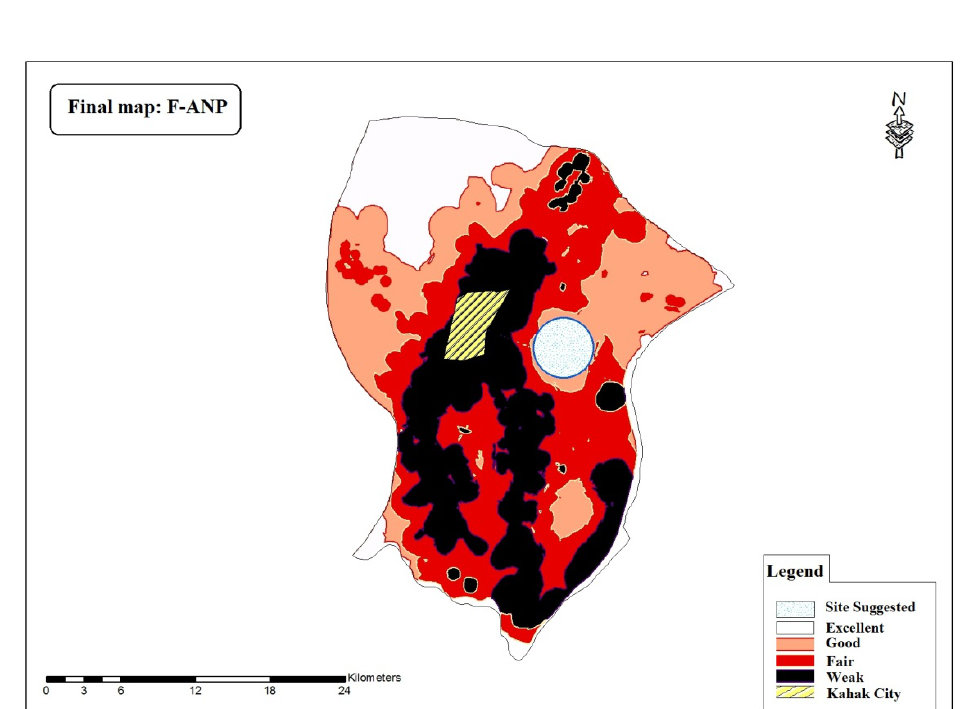
Figure 9. Final fuzzy logic and analytic network process map indicating the most suitable site for wastewater treatment